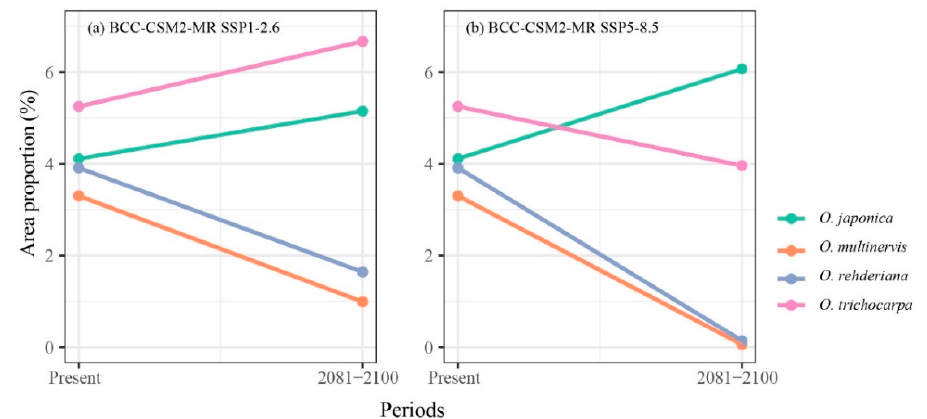
Figure 4. Great probability habitat proportion shifts of four Ostrya species under climate scenarios, i.e., BCC-CSM2-MR SSP1-2.6 ( a ), and BCC-CSM2-MR SSP5-8.5 ( b ), between the present and 2081–2100 periods.